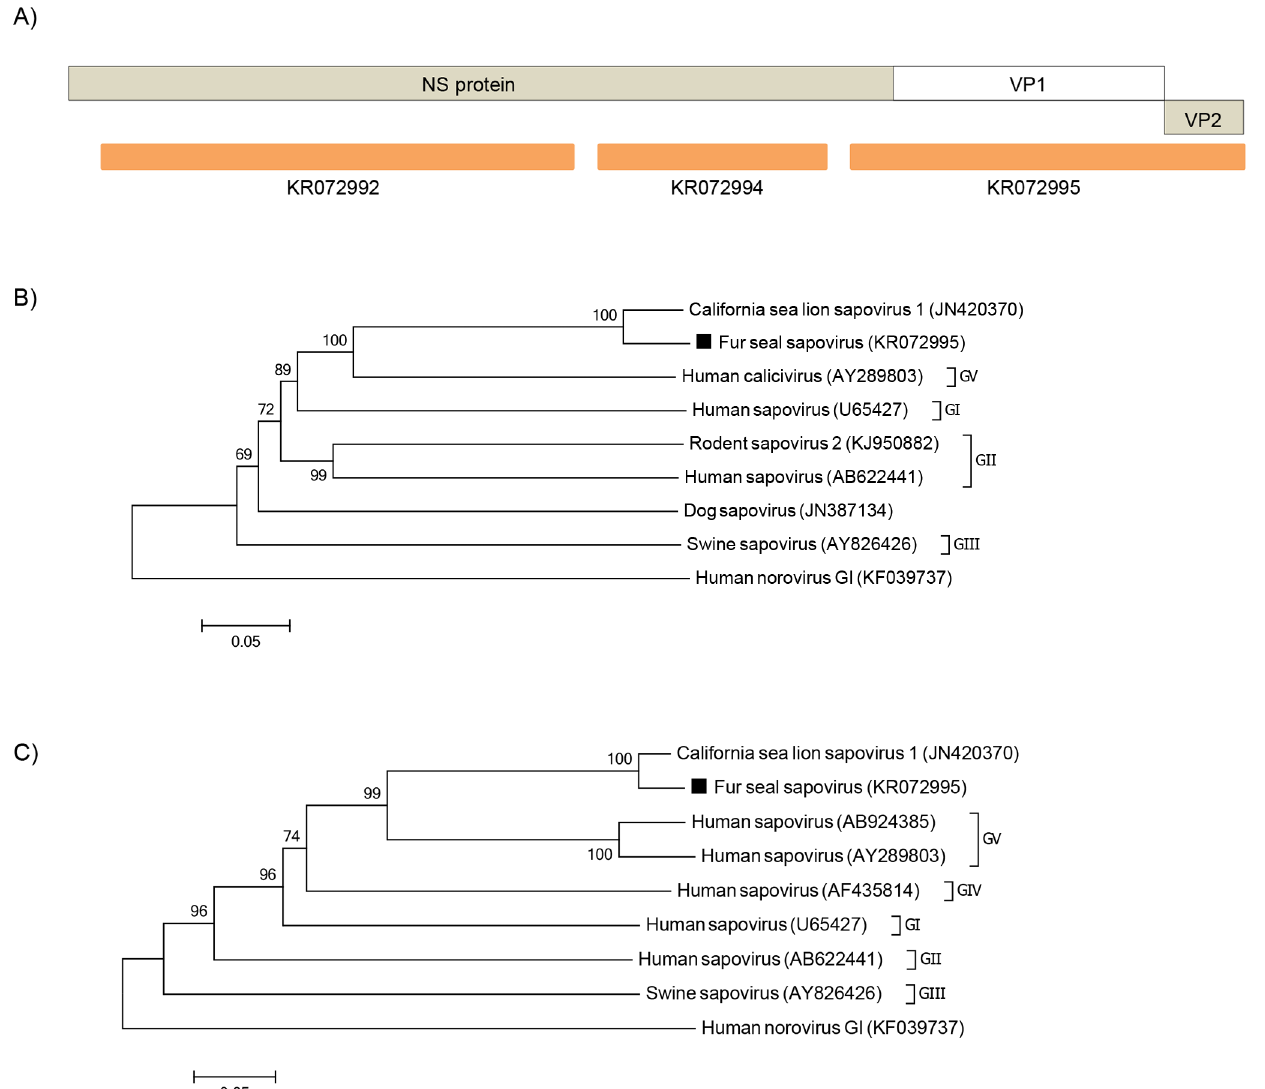
Fig 10. Phylogenetic analysis of fur seal sapovirus. (A) Schematic representation of the genome of sapoviruses using California sea lion sapovirus 1 (~7.5 kb — JN420370.2) as a reference. The orange bars represent the contigs from Subantarctic fur seal. (B) Neighbor-joining phylogenetic tree based on complete nucleotide sequences from the VP1 gene of 9 caliciviruses. Human norovirus was used as outgroup. (C) Neighbor-joining phylogenetic tree based on the alignment of nearly-complete nucleotide sequences from the VP2 gene of 9 caliciviruses. Human norovirus was used as outgroup. The sapovirus sequences from Subantarctic fur seal from this study used in phylogenetic analyses are labeled with a black square. The GenBank accession numbers of the viral sequences are shown in